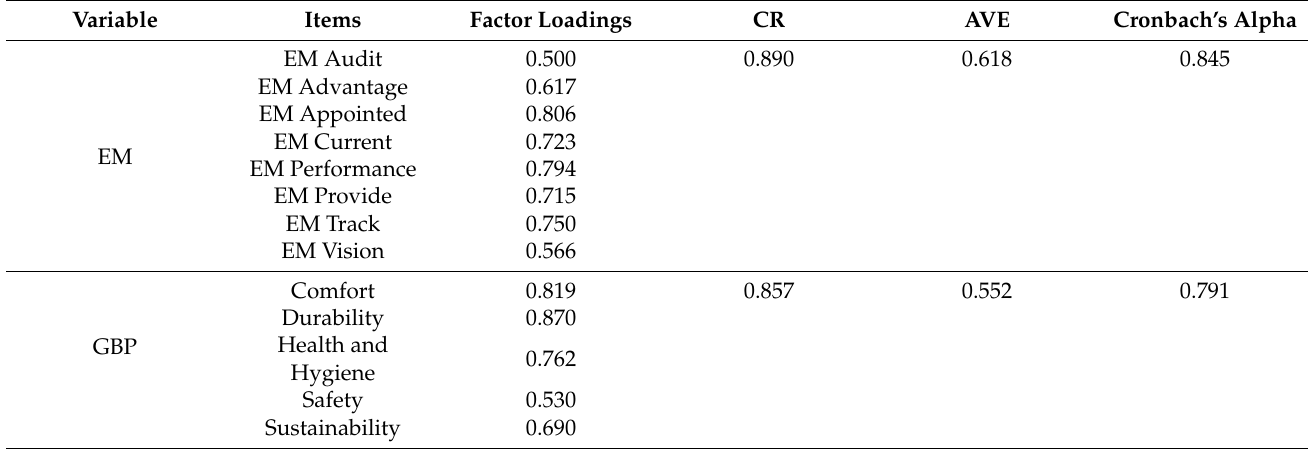
Table 3. The results of convert